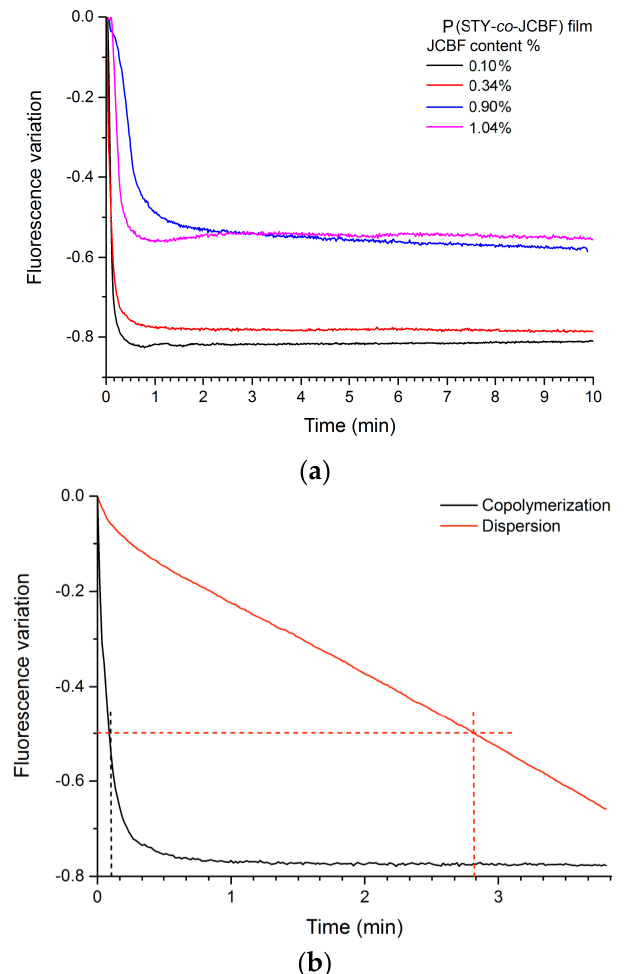
Figure 4. ( a ) Variation of the fluorescence maximum intensity ( λ exc. = 410 nm) with exposure time to chloroform vapours for all P(STY-co-JCBF)(m) films. Fluorescence was collected for a total time of 10 min in each experiment. ( b ) Comparison between P(STY-co-JCBF)(0.34) and the most sensitive julolidine-based Fluorescent Molecular Rotors (FMR) dispersed in polystyrene (PS) [28] towards chloroform vapours.